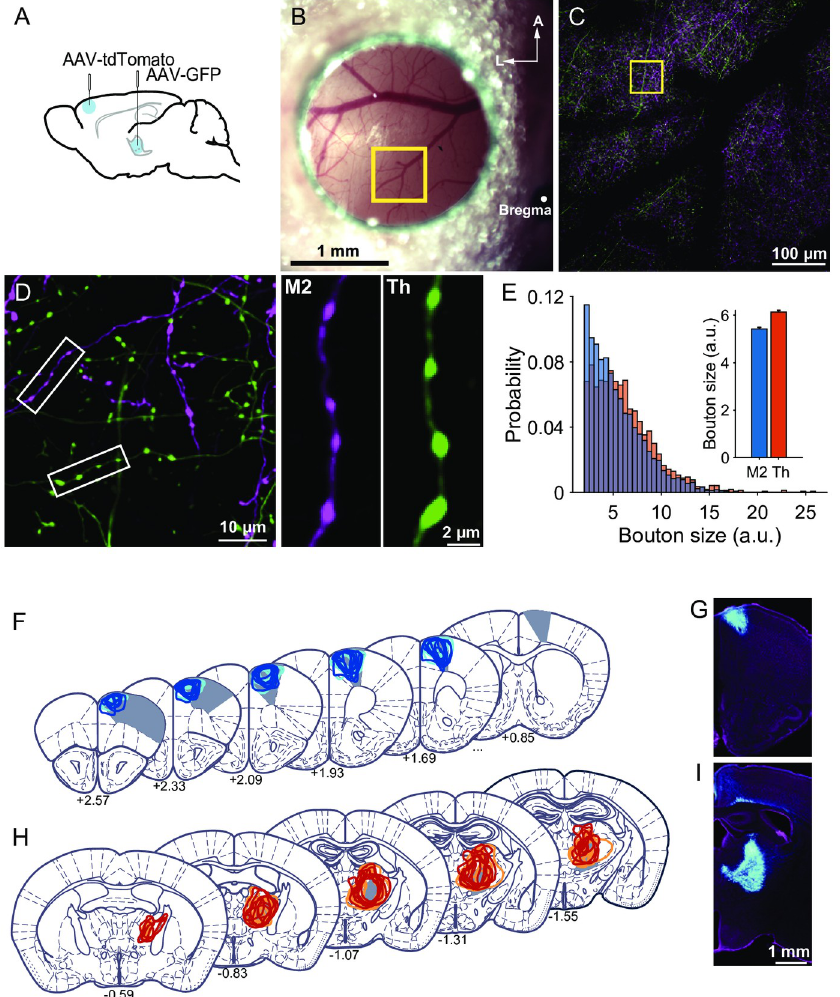
Fig 2. Two-photon imaging of M2 boutons and thalamic boutons. (A) Schematic illustration of the AAV injection. (B) Representative image of the M1 cranial window on the mice in which tdTomato was expressed in M2 neurons and GFP was expressed in thalamic neurons. A, anterior; L, lateral. (C) Maximum intensity projection of the two-photon images of the boxed area in (B). The images were acquired at depths of 0–100 μ m from the brain surface. (D) Left, two- photon image of the boxed area in (C). The depth of the imaging plane was 30 μ m. Right, images of an axon originating from M2 (left) and a thalamocortical axon (Th; right). (E) Left, the distribution of the size of all imaged M2 (blue) and thalamic (orange) putative boutons on the first imaging day (day 0; M2 boutons: n = 1793 from 16 mice; thalamic boutons: n = 1702 from 15 mice). Right, the mean size of M2 and thalamic (Th) boutons. The data include both trained and untrained mice. p < 1 × 10 − 10 (Kolmogorov–Smirnov test). (F, H) Localization of AAV injection sites. The infected area in each mouse is shown as colored lines. Filled gray areas indicate M2 (F), or VA, VL, and VM (H), according to Paxinos and Franklin [55]. Anteroposterior distance (mm) from the bregma is indicated for each section. Blue represents trained mice with M2 injection, and cyan represents control mice with M2 injection; red represents trained mice with thalamic injection, and orange represents control mice with thalamic injection. (G, I) Representative images of AAV-infected neurons (cyan) in M2 (G) and the motor thalamus (I). NeuroTrace counterstaining is shown in